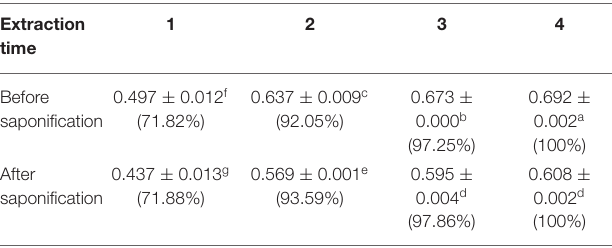
extractions was set as 100%.